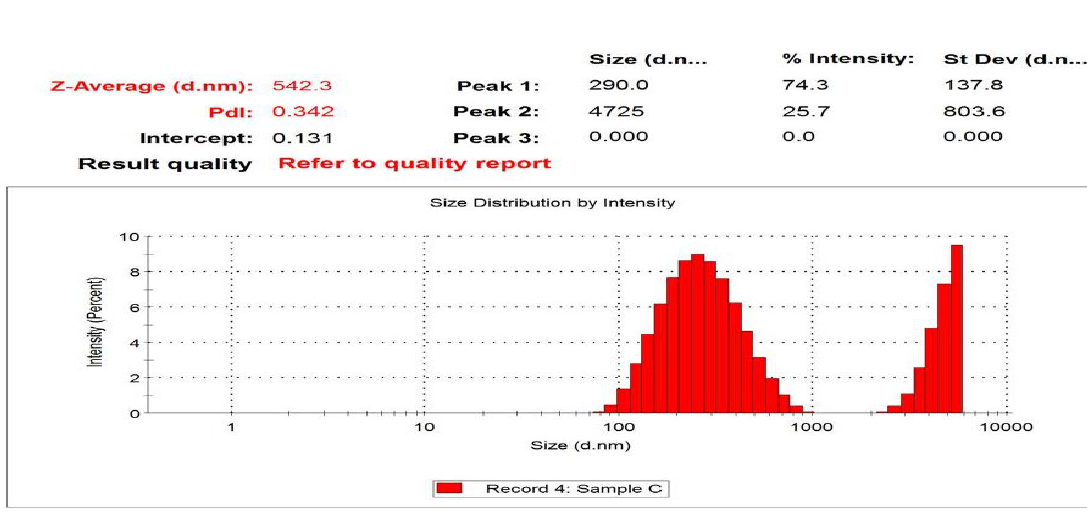
Figure 4: Particle size distribution by percentage